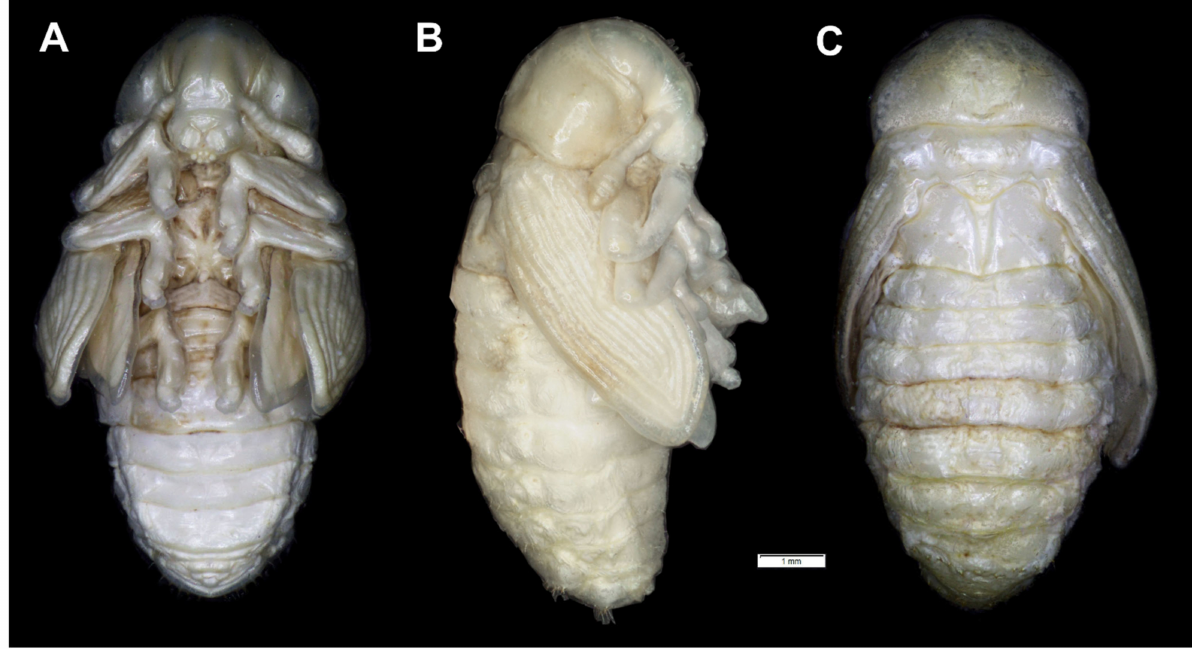
Figure 21. Rhinocyllus conicus habitus of pupa. ( A )—ventral view; ( B )—lateral view; ( C )—dorsal view. Chaetotaxy well-visible, with setae of various lengths from medium to short on abdom- inal segments VII and VIII placed on small protuberances. Head with three pas , two os and three sos , rostrum without setae. All setae on head equal in length, medium (Figure 22A–C). Pronotum with two ls , three sls , two ds , and four pls equal in size. Meso- and metathorax with three medium setae placed medially on dorsum. Each femora with two medium, hair-like setae (Figure 22A). Abdominal segments I–VII with seven (segment VIII with six) medium setae (the first placed medially, the next placed along anterior margins of each of the segments). Setae on abdominal segments VII and VIII placed on protuberances (Figure 22D). Abdominal segment IX with four minute setae placed ventrally. Each lateral part of abdominal segments I–VIII with two minute setae. Ventral parts of abdominal segments I–VIII with three setae. Urogomphia invisible (Figure